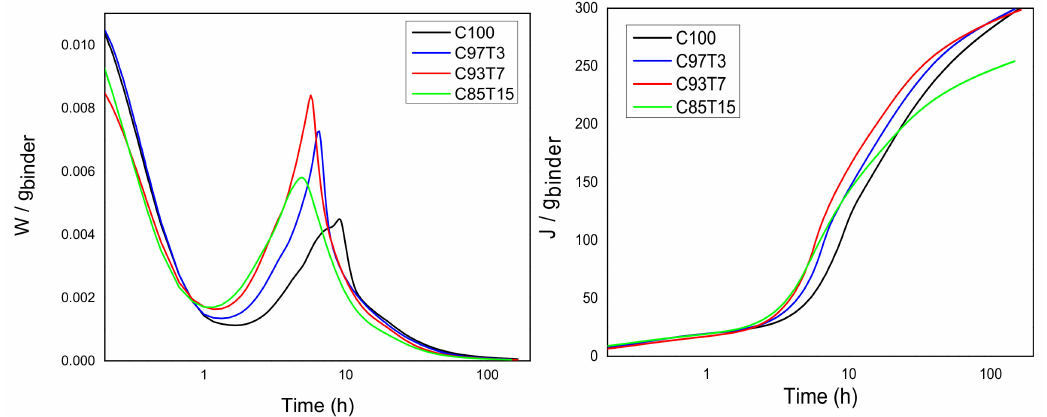
Figure 1. Isothermal calorimetry measurement. Power versus hydration time and heat release versus hydration time divided by the total solid mass.